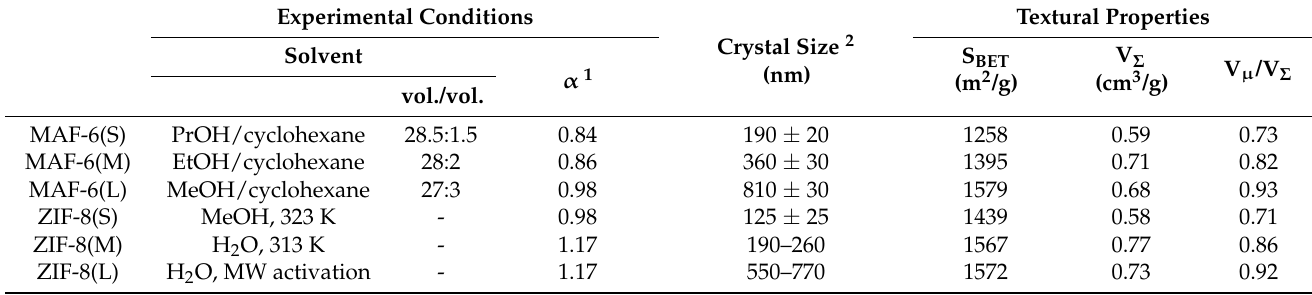
Table 5. Synthesis, textural properties, and crystal sizes of ZIF-8, MAF-6, and MAF-5 samples. Experimental Conditions